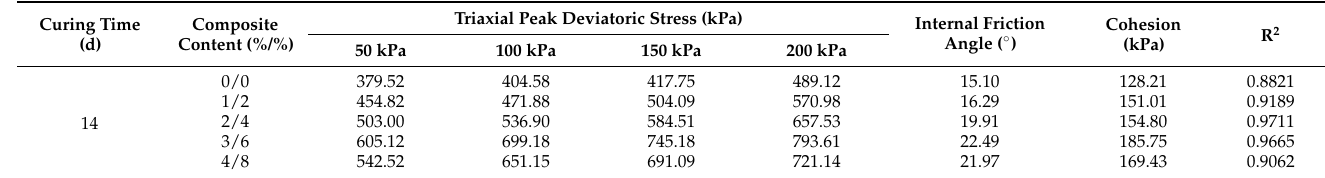
Table 4. Triaxial shear test result parameters of composite